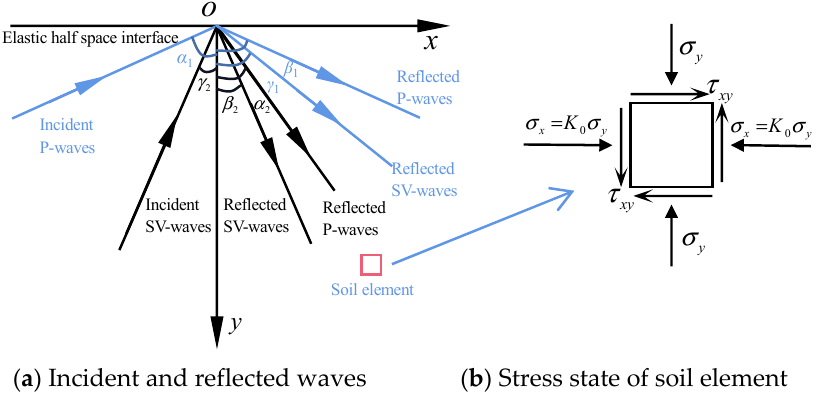
Figure 2. Diagrammatic sketch of obliquely incident P- and SV-waves on elastic half-space interface.